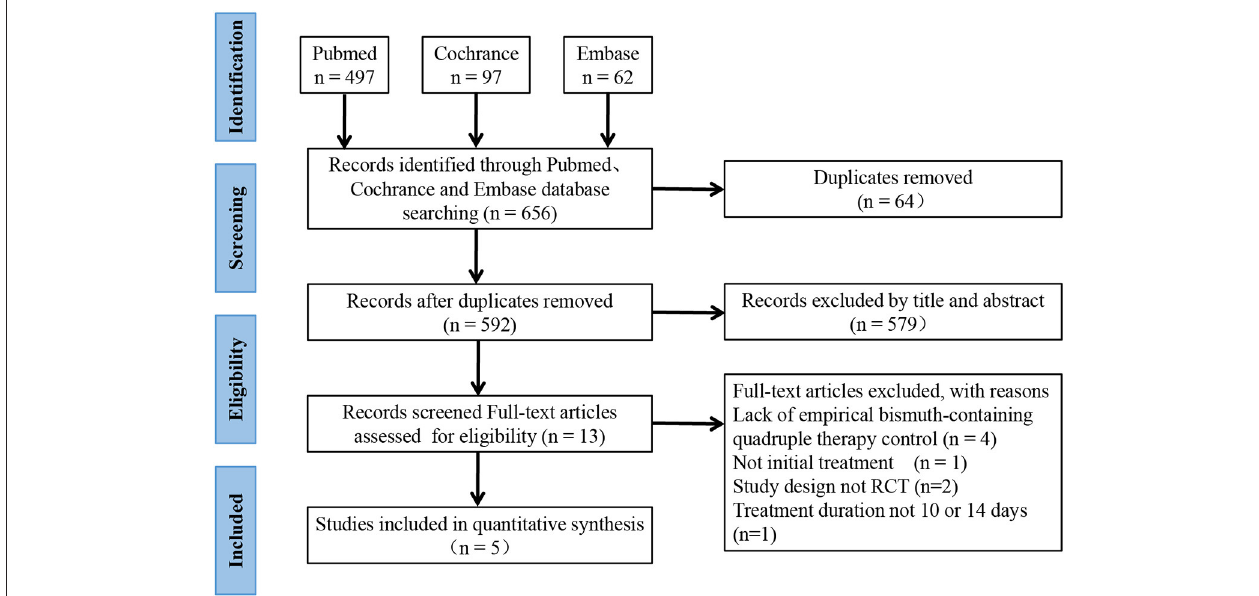
FIGURE 1 | A flowchart of the details of this